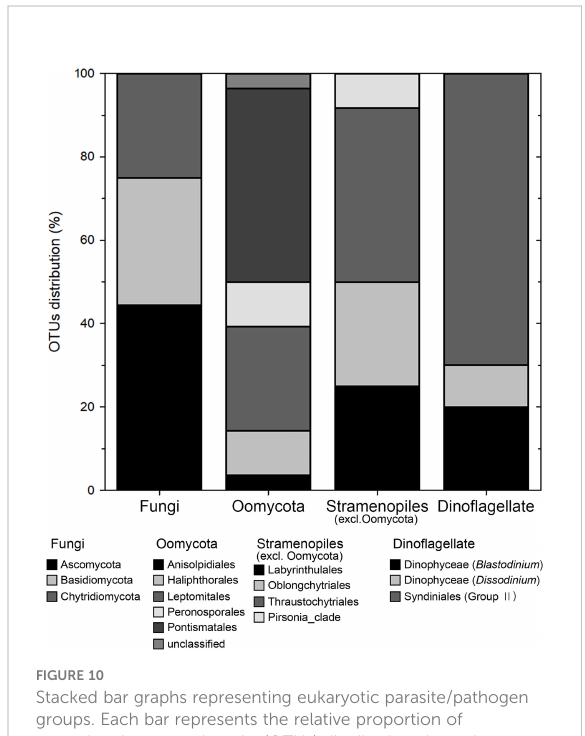
FIGURE 10 Stacked bar graphs representing eukaryotic parasite/pathogen groups. Each bar represents the relative proportion of operational taxonomic units (OTUs) distributions in each